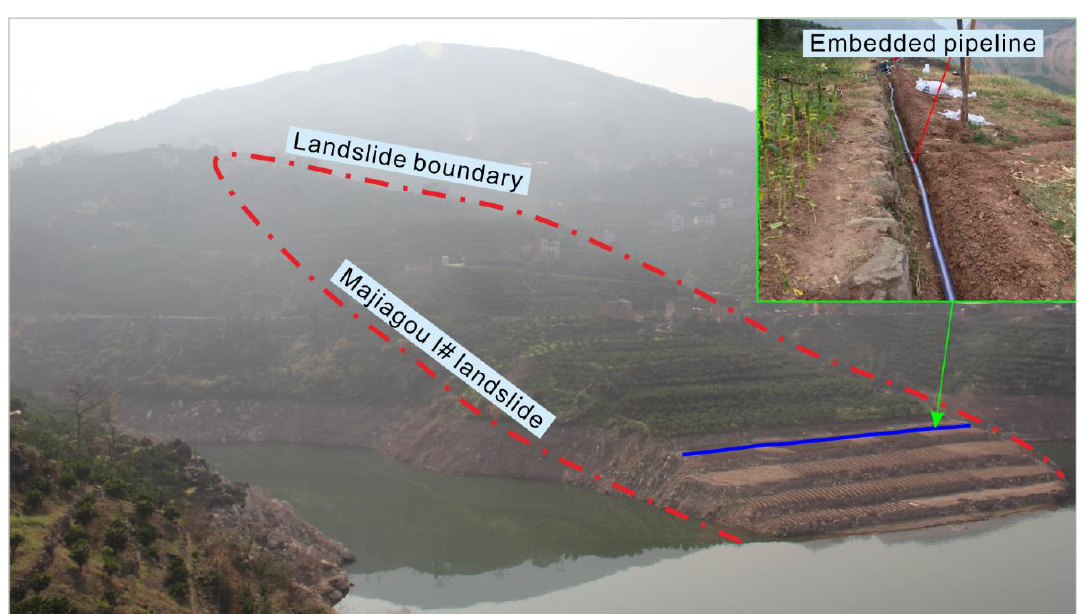
Figure 12. Majiagou I# landslide test site.